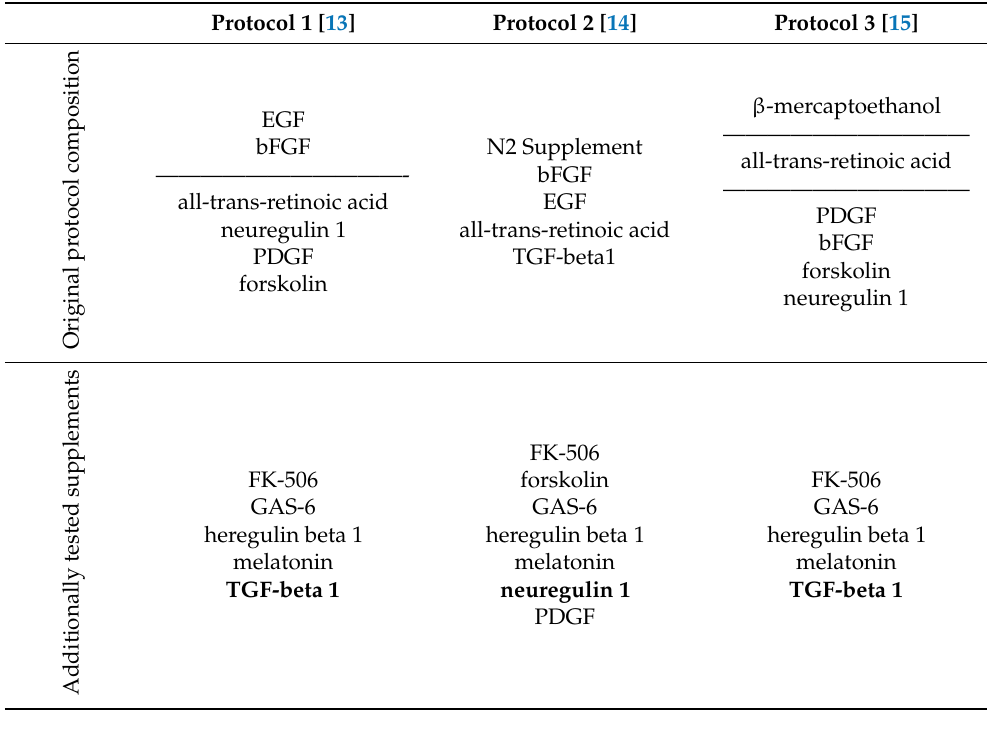
Table 1. Compositions of the three original protocols taken from the literature, and the compounds that these protocols were supplemented with. The highlighted compound showed the strongest enhancement of the original protocol, and it was used for all further experiments. The original Protocol 1 includes two steps, and the original Protocol 3 includes three steps with different media compositions. The additional supplementation was tested for the last step of each